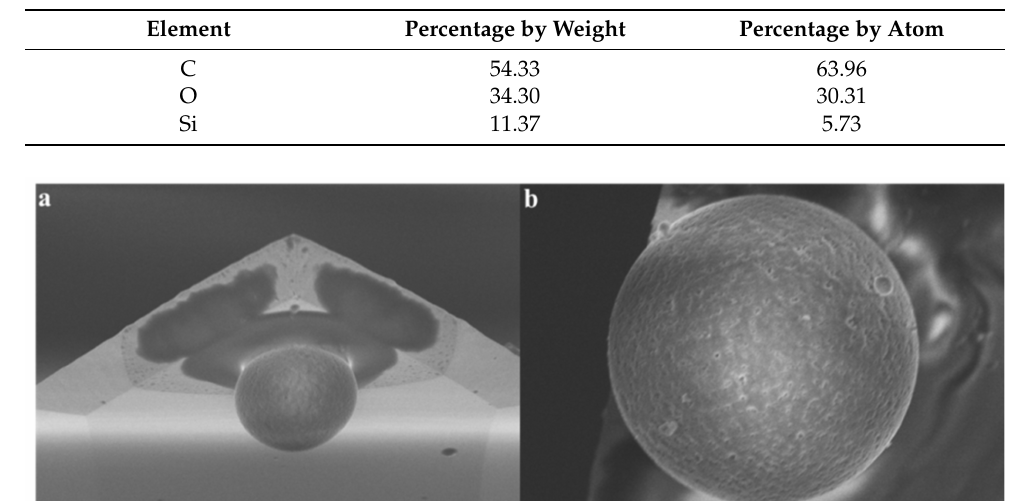
Table 1. Element analysis of SiO 2 sphere covered with heavy oil.